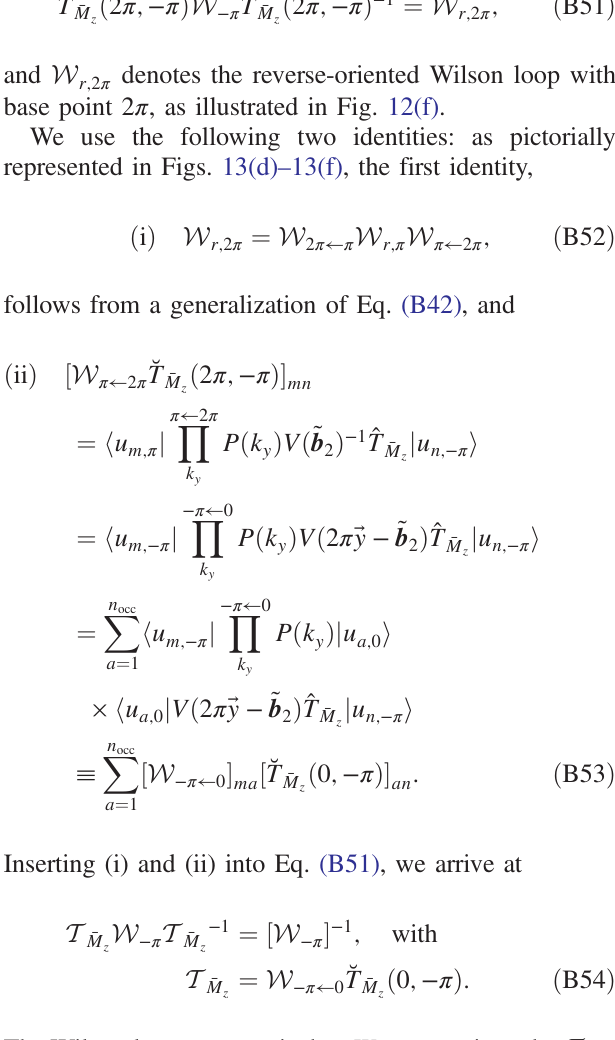
þ indicating an insertion þ